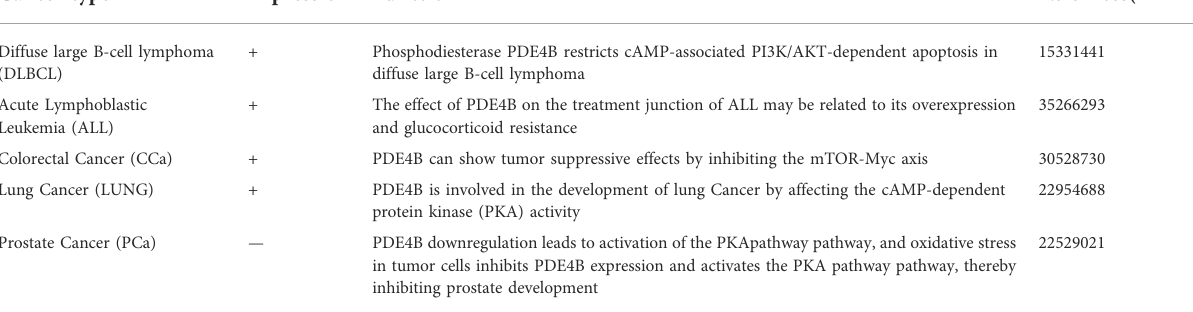
TABLE 1 The relationship between abnormal PDE4B expression and in fl ammatory processes demonstrates the important role of PDE4B in in fl ammation. Cancer